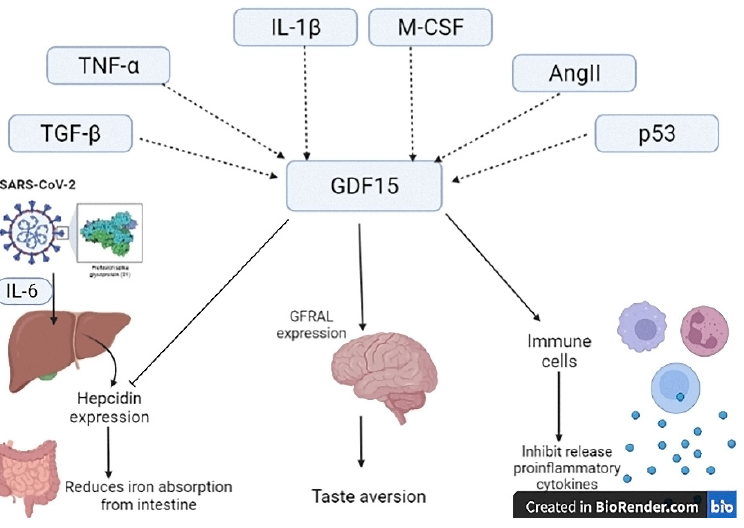
Figure 1. Activation of growth differentiation factor 15 (GDF15) and its action. GDF15 is activated by TGF- β (transforming growth factor- β ), TNF- α (tumor necrosis factor- α ), IL (interleukin)-1 β , M-CSF (macrophage colony-stimulating factor), AngII (angiotensin II) and p53. GDF15 stimulates immune cells and activates glial-derived neurotrophic factor family receptor α -like (GFRAL) in the brain. In addition, GDF15 counteracts hepcidin which increased in various viral infections including SARS-CoV-2 due to the elevation of IL-6.